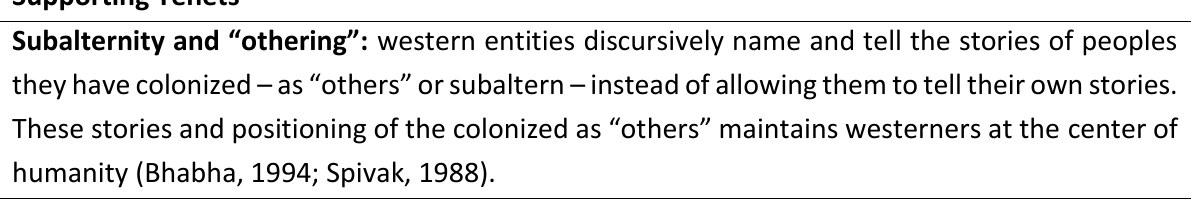
Table 1. Postcolonialism (alexander, 2022) Supporting Tenets